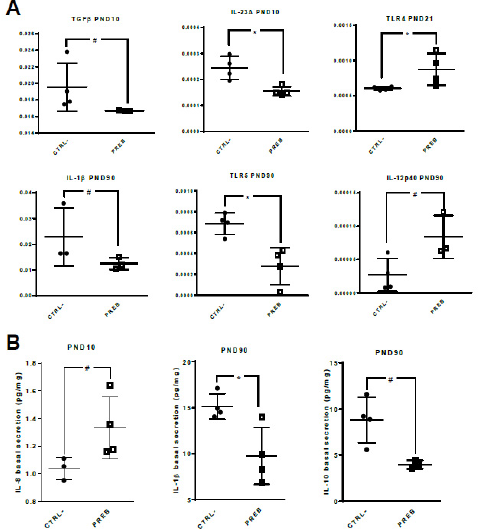
Figure 5. Sow diet prebiotic supplementation effect on gene expression and cytokine patterns of unstimulated il ‐ PP explants. Datasets were analyzed using the non ‐ parametric Mann ‐ Whitney test. ( A ) qRT ‐ PCR gene expression from unstimulated il ‐ PP explants of CTRL ‐ ( n = 3–4, full circle) and PREB ( n = 3–4, empty square) piglets. The relative gene expression was determined using the cycle threshold (Ct) method and normalized to the expression of the two housekeeping genes (Ct of gene of interest over mean Ct). Differences in il ‐ PP explant gene expression levels between CTRL ‐ vs. PREB are displayed with * p < 0.05, # p < 0.10. ( B ) Cytokine secretion in unstimulated il ‐ PP explant from CTRL ‐ ( n = 3–4, full circle) and PREB ( n = 3–4, empty square) piglets. Differences in il ‐ PP explant cytokine secretion between CTRL ‐ vs. PREB are displayed with * p < 0.05, # p < 0.10. 3.4. Sow Diet. Prebiotic Supplementation Changed Gene Expression and Cytokine Patterns of il ‐ PP Explants Stimulated with TLR ‐ ligands. We also tested the gene expression and cytokine secretion of il ‐ PP explants stimulated with 1 μ g/mL flagellin or with 50 μ g/mL LPS. At PND10, stimulated PREB il ‐ PP explants displayed increased gene expression of TGF β ( p < 0.06 with flagellin), IL ‐ 23A ( p < 0.03 with flagellin and LPS) and FoxP3 ( p < 0.06 with LPS) compared to CTRL ‐ il ‐ PP explants. At PND21, IL ‐ 10 ( p < 0.06) and CX3CL1 ( p < 0.06) gene expression tended to be down ‐ regulated in flagellin ‐ stimulated PREB il ‐ PP explants compared to flagellin ‐ stimulated CTRL ‐ il ‐ PP explants. At PND90, TLR5 gene expression tended to be up ‐ regulated ( p < 0.06) in LPS ‐ stimulated PREB il ‐ PP explants compared to LPS ‐